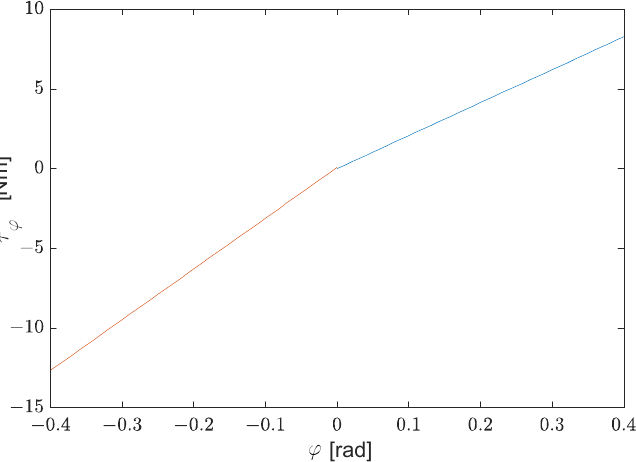
Figure 24. Perturbation for an abduction (blue line)-adduction (red line) movement.